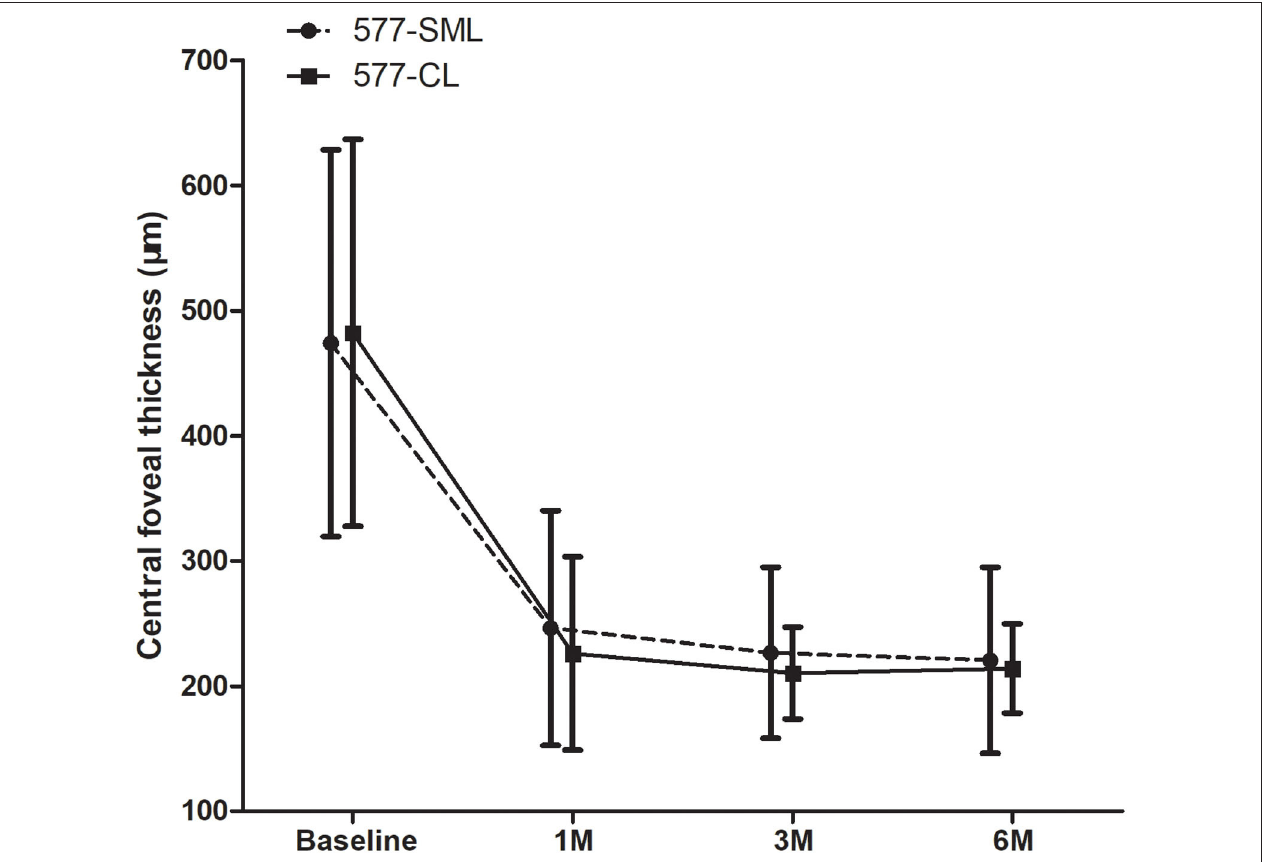
FIGURE 3 | The change of mean CFT during baseline and visits. CFT showed a statistically significant reduction at each visit compared with the baseline in each group ( p < 0.05). Whereas, there was no significant difference between 577-nm SML group and 577-nm CL group ( p > 0.05). CFT, central foveal thickness. SML, subthreshold micropulse laser. CL, conventional